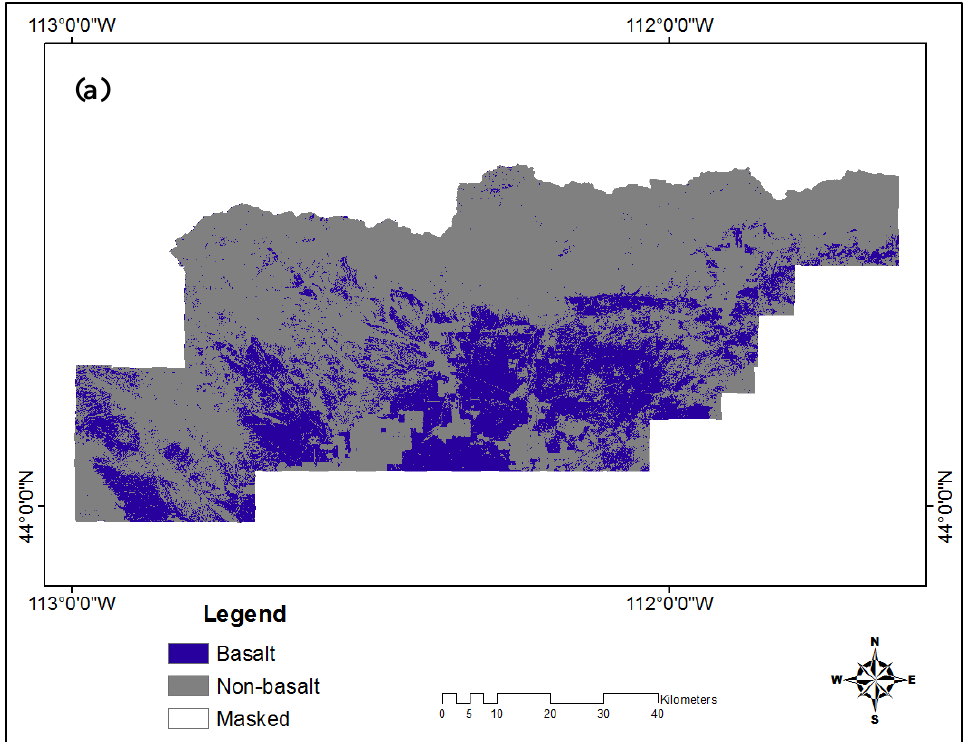
Figure 4. Basalt mapping results obtained from 18 July Landsat scene using the Robust Classification Method (RCM) and the Spectral Angle Mapper (SAM) method, in Clark County, ID, USA. Average overall classification accuracy is 60.45%. ( a ) A classification uncertainty map was also generated by calculating where the percent majority is the percent of repetitions (60) that resulted in the pixel being assigned to the majority